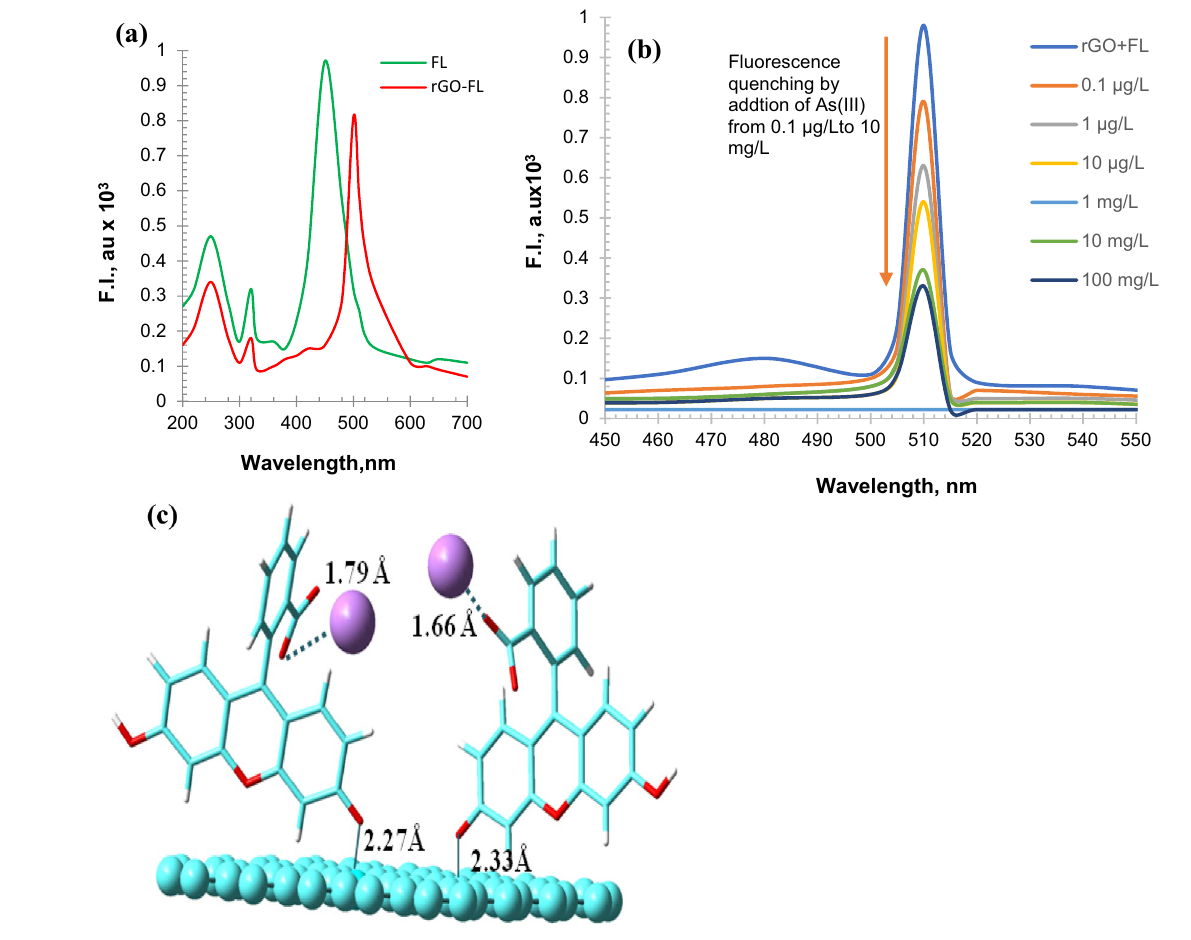
Figure 4. ( a ) Fluorescence emission spectra of FL and rGO–FL showing red shift during formation of nanocomposite ( b ) Fluorescence titration spectra of rGO and FL in aqueous solution. The fluorescence emission was observed at 510 nm when the sample was excited at 348 nm and the increase in concentration of As(III) reduce the fluorescence intensity ( c ) Molecular model of rGO–FL nanoparticles interaction with As(III) simulated in vacuum using Gaussian Ver. 4.2.1 software; https:// gauss ian. com/